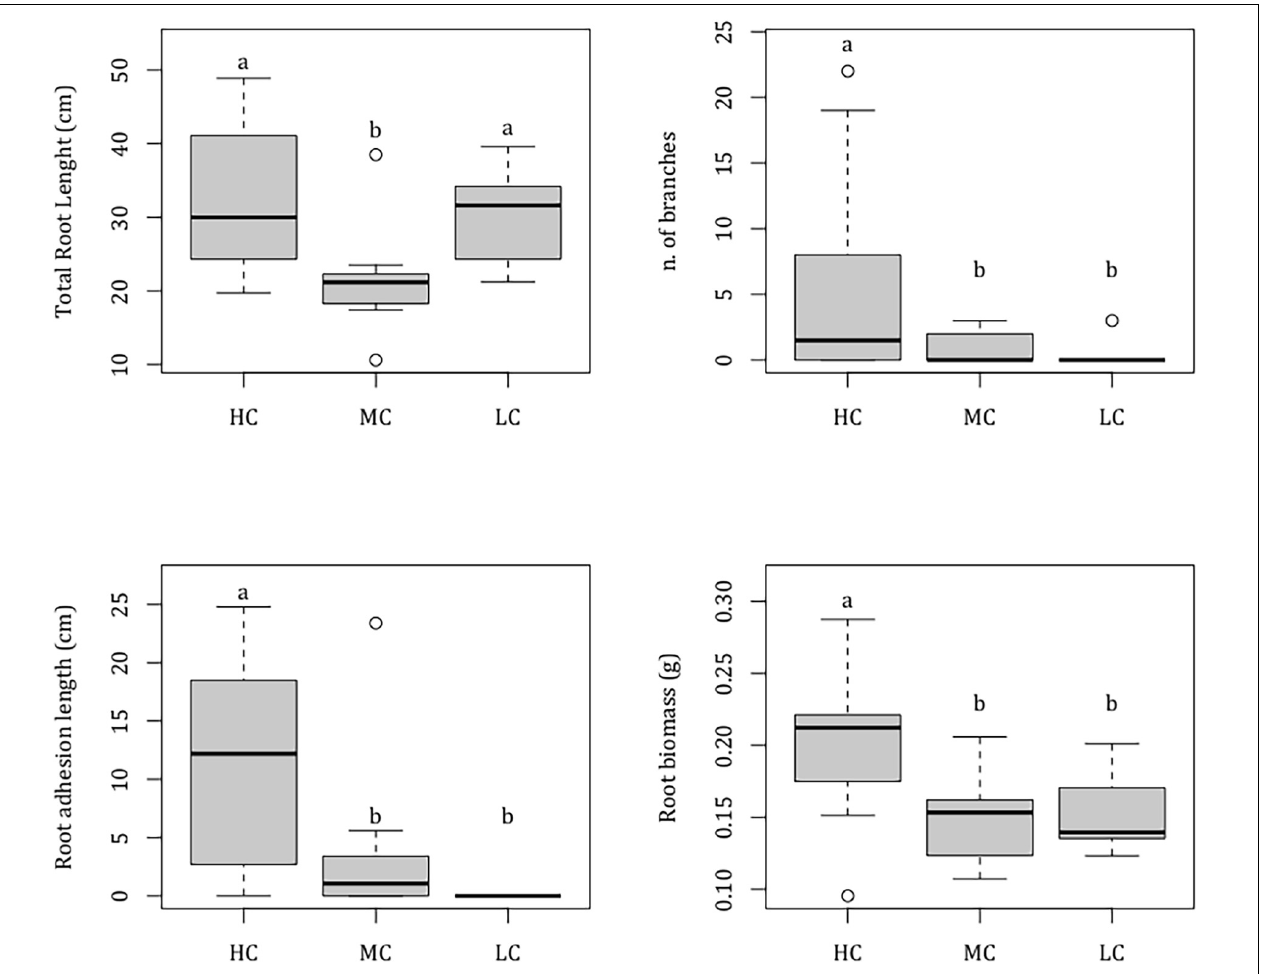
FIGURE 3 | Boxplots showing the effect of substrate complexity (Co) on seedling morphological and biomass variables (total root length, n. of root branches, root adhesion length, and root biomass). Results are showed only for variables for which a significant effect of factor Co was detected. HC = high complexity; MC = medium complexity; LC = low complexity; Median = horizontal line; 25 th and 75 th percentiles = vertical boxes; 10 th and 90 th percentiles = whiskers. n = 10 for each complexity level. Letters above bars indicate significant differences between experimental